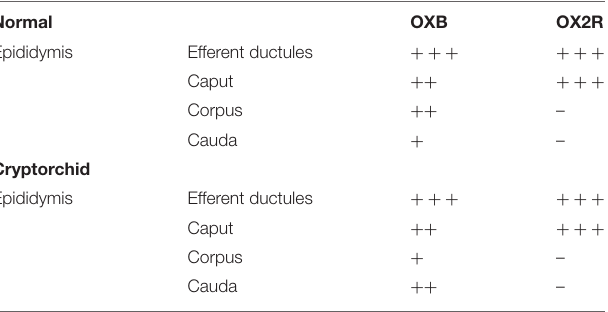
TABLE 3 | Immunohistochemical density of OXB and OX2R IRs in the epididymal efferent ductules and epididymis of normal and cryptorchid dogs.